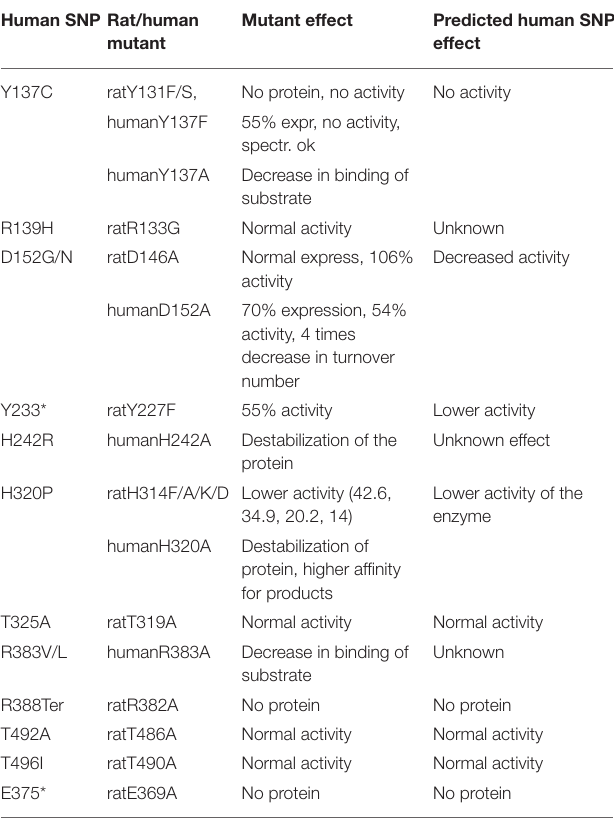
TABLE 2 | Human SNP and rat/human in vitro mutant